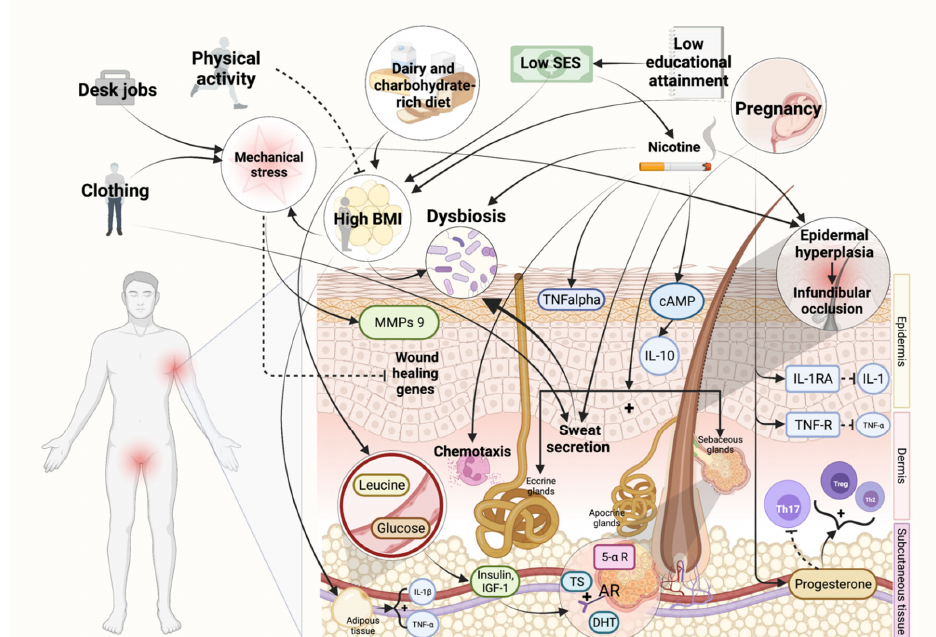
Figure 1. The main trigger factors involved in HS. For a detailed explanation, see the text. Image created with BioRender.com. Abbreviations: BMI, body mass index; SES, socioeconomic status; MMPs, matrix metalloproteinases; TNF— α , tumor necrosis factor alpha; TNF ‐ R, tumor necrosis fac ‐ tor receptor; IL, interleukin; cAMP, cyclic adenosine monophosphate; IGF ‐ 1, insulin ‐ like growth factor 1; AR, androgen receptor; TS, testosterone; DHT, dihydrotestosterone; 5 ‐α R, 5 ‐α‐ reductase; IL ‐ 1RA, interleukin 1 receptor antagonist. Information extracted from references [1,44,55– 59,61,64,74,80,93,94,125,153,154]. 15. HS and Sleep Sleep impairment is an often ‐ overlooked aspect that severely impacts the QoL of HS patients. Skin and sleep interact at multiple levels. Indeed, skin plays a role in both sleep onset and thermoregulation, whereas circadian rhythms (and their influence on cortisol levels) might affect skin symptoms [156]. Notably, both pain and itching, two prominent and disabling symptoms of HS, adversely affect sleep quality (Figure 2). In a cross ‐ sec ‐ tional study examining the prevalence and the characteristics of pruritus in HS patients, Vossen et al. observed that 70% of patients reported an impact of itch on different aspects of sleep [157]. Kaaz and colleagues, in their case–control study involving 108 HS patients and 50 controls, assessed the influence of pain and itch on sleep. The researchers found that, compared to controls, patients with HS did not have significantly more frequent in ‐ somnia (evaluated by the Athens Insomnia Scale—AIS) but did have significantly more sleep disturbances (evaluated by the Pittsburgh Sleep Quality Index—PSQI). Specifically, pain played a crucial role in determining subjective sleep quality, sleep duration and day ‐ time dysfunction (Figure 2) [158]. It has also been suggested that HS might be related to a higher risk of obstructive sleep apnoea (OSA), a clinical condition characterized by airway collapse and subsequent hypoxia during sleep. In this regard, both these conditions share common risk factors, such as obesity and smoking. Furthermore, OSA might further worsen already poor sleep quality in HS patients. In a cross ‐ sectional study analyzing the